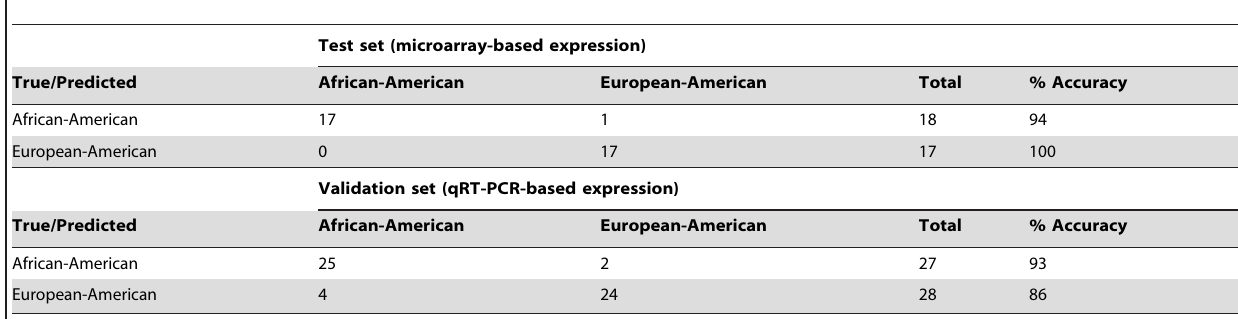
Table 4. Classification of tumors by race/ethnicity with a two-gene signature consisting of PSPHL and CRYBB2